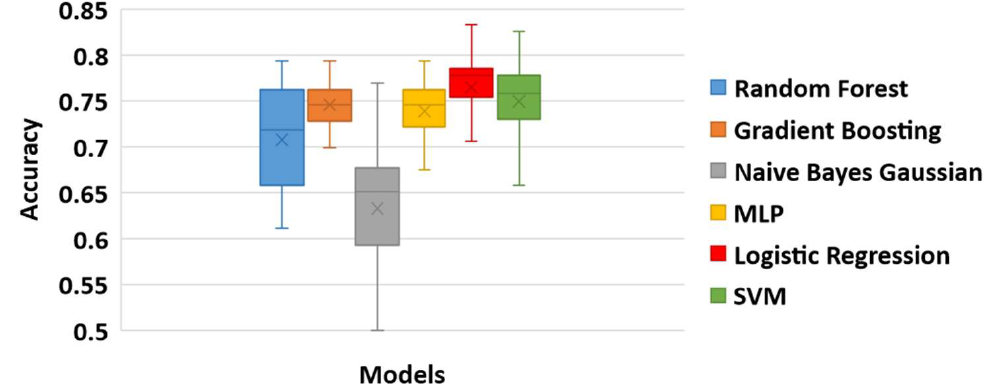
Figure 11. The box plot of the prediction models based on their performance for the right and left legs combined.